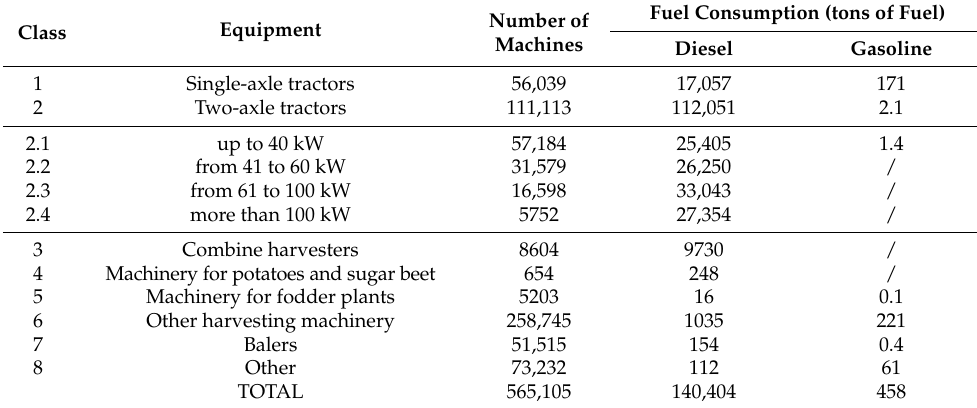
Table 4. Number of agricultural machines and diesel and gasoline fuel consumption for all machin- ery